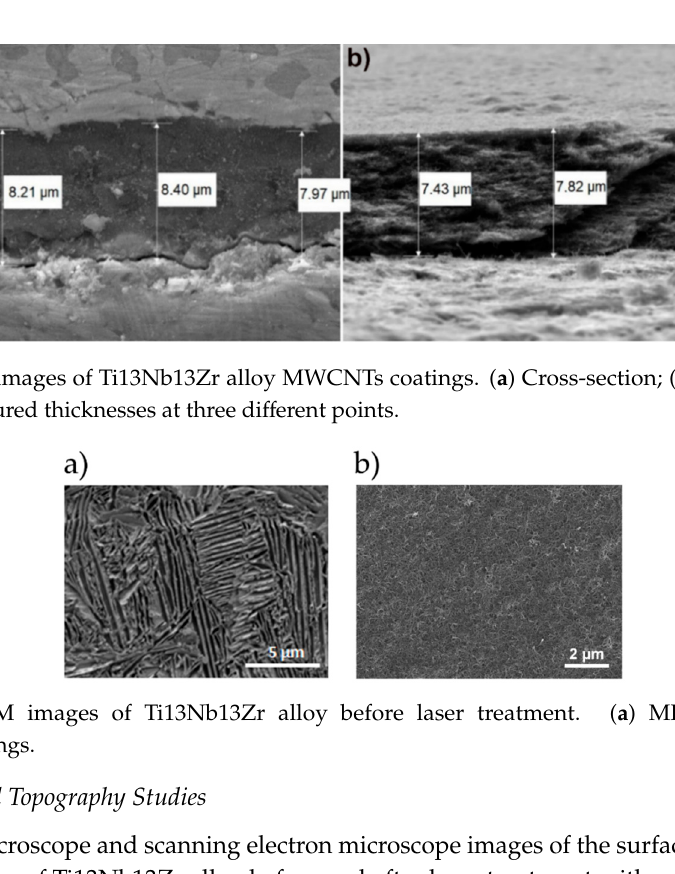
Figure 4. SEM images of Ti13Nb13Zr alloy after laser processing. ( a ) Surface topography; ( b ) cross- sections; ( c ) images from an optical microscope.